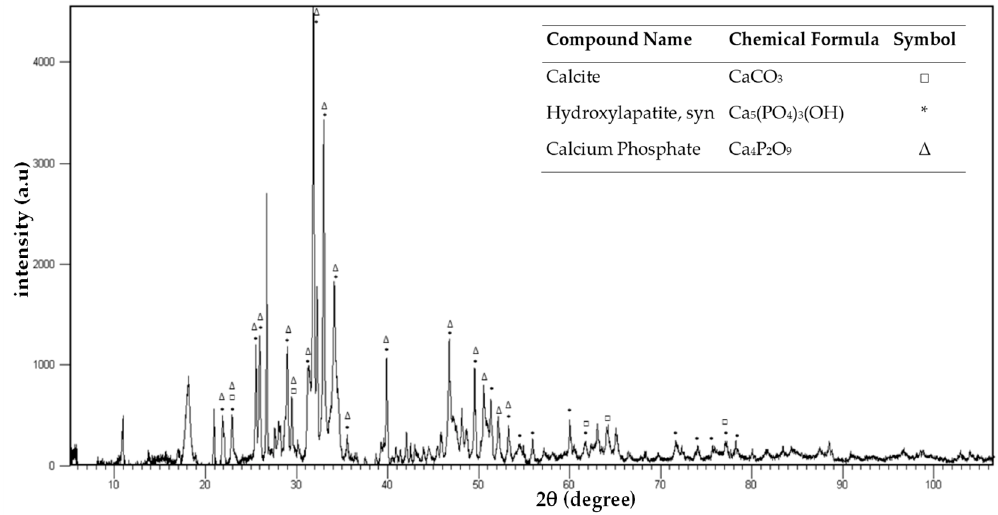
Figure 4. Di ff raction pattern of poultry ash. Figure 4. Diffraction pattern of poultry ash.